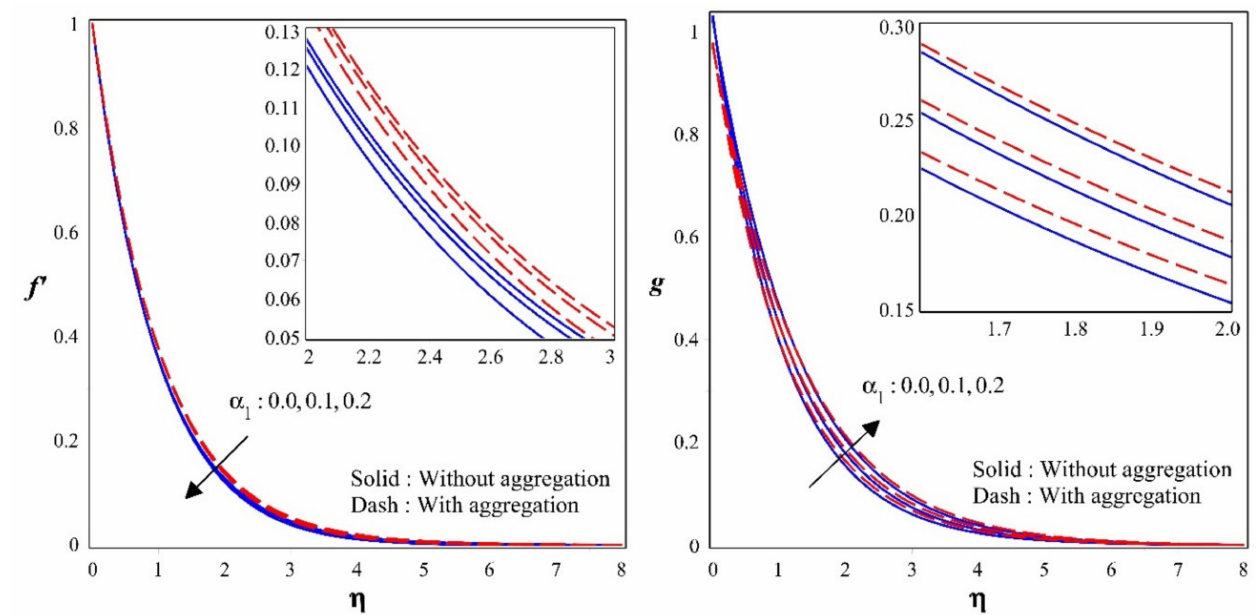
Figure 3. Sway of f (cid:48) & g for different values of α 1 .